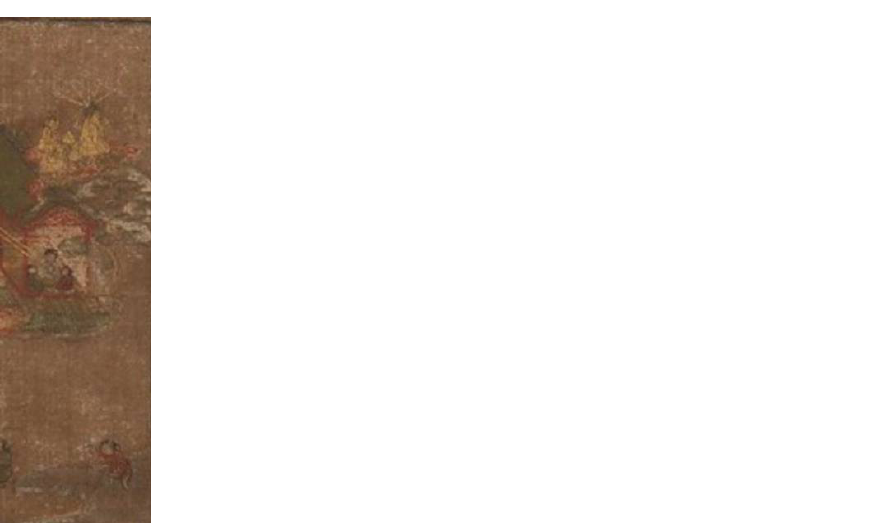
Figure 3. Taima mandara (mandala), detail of Figure 1 showing one of the nine possible degrees of rebirth, The Metropolitan Museum of Art (artwork in the public domain). Source: The Metropolitan Museum of Art, published under fair use.